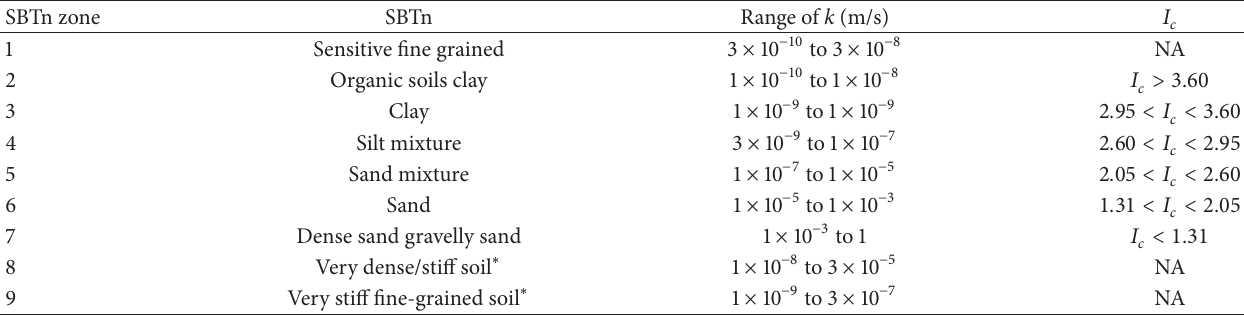
Table 1: Estimated soil permeability ( 𝑘 ) based on normalized CPT soil behavior type (SBTn) by Robertson [2] (modified from Lunne et al., [11]).